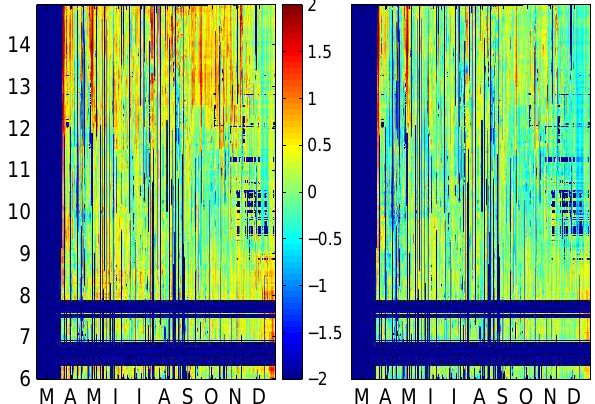
Fig. 13. Differences in the daily morning surface heating rates [Kh − 1 ] (same transect Fig. 12): simulated heating rates using ECOCLIMAP-I vs. LSA-SAF LST (left), simulated heating rates using LSA-SAF LAI vs. LSA-SAF LST (right).